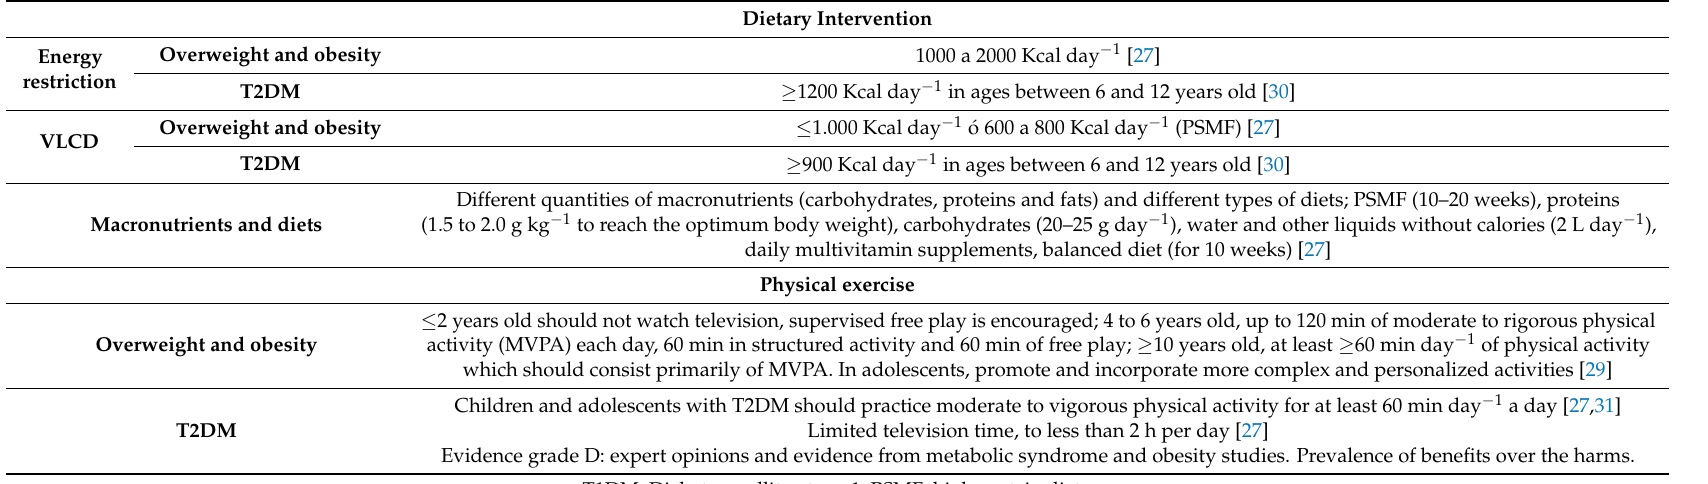
T1DM: Diabetes mellitus type 1; PSMF: high protein